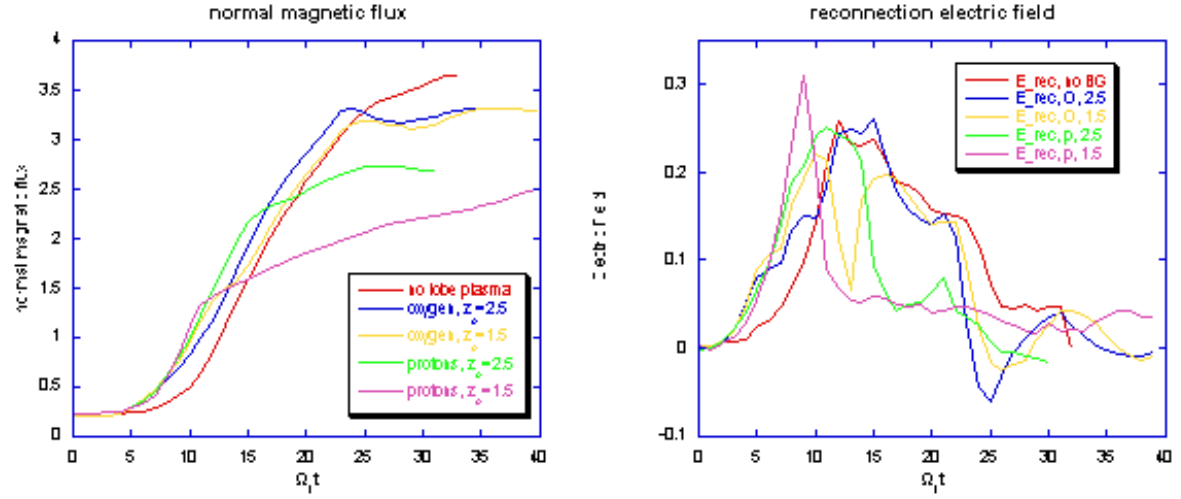
Fig. 2. Time evolution of the magnetic flux threading the current sheet (left panel), and reconnection electric field (right panel). Different graphs are for different runs. The evolution of magnetic reconnection is nearly identical for the runs involving background oxygen and the run without any background populations. Depending on the distribution of background protons, those runs feature strong reductions in the reconnection rate.